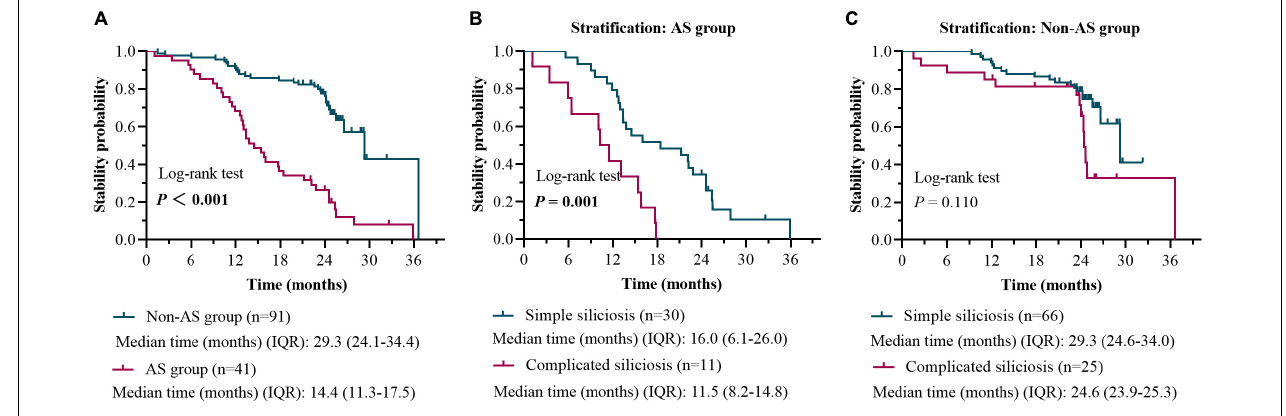
FIGURE 5 | HRCT stability rate in patients with the AS group versus the non-AS group during 0-to-2-year follow-up (A) . HRCT stability rate in patients with simple silicosis versus the complicated silicosis in the AS group during 0-to-2-year follow-up (B) . HRCT stability rate in patients with simple silicosis versus the complicated silicosis in the non-AS group during 0-to-2-year follow-up (C)